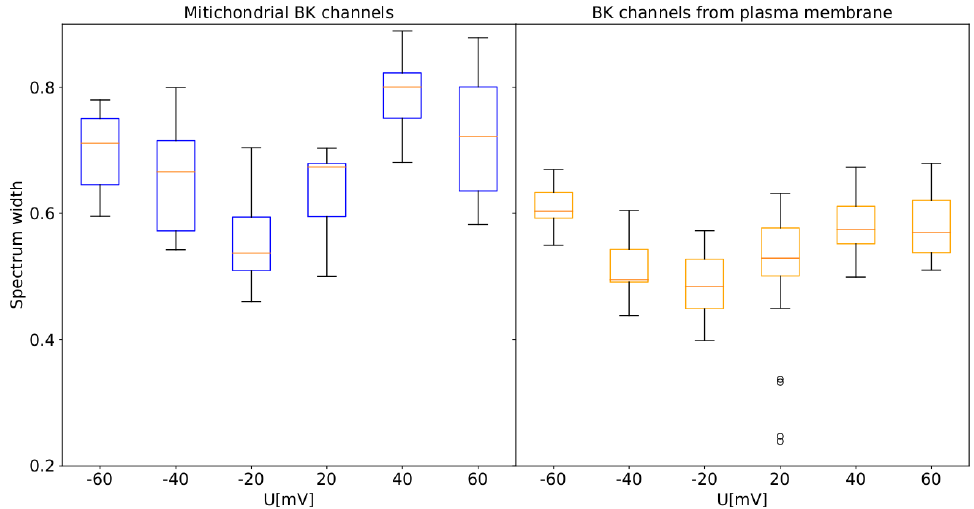
Figure 8. Box plots of the spectrum width obtained for the single-channel recordings for mitochondrial ( blue ) and cellular patches ( orange ) at different membrane potentials. The boxes extend from the lower to upper quartile values. The line inside the box characterizes the median value and the whiskers represent the range of data. Outlier points are those which exceed the ends of the